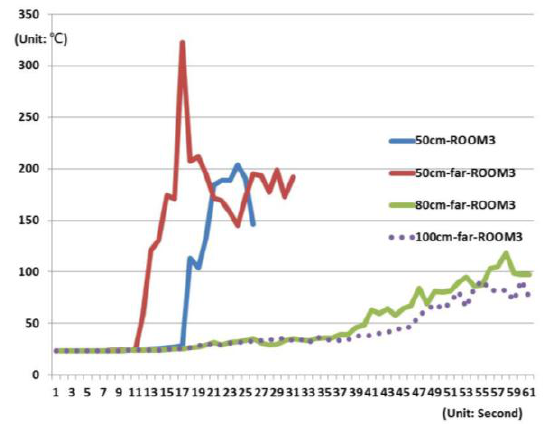
Figure10. Temperature variation occurred in the third room of the left